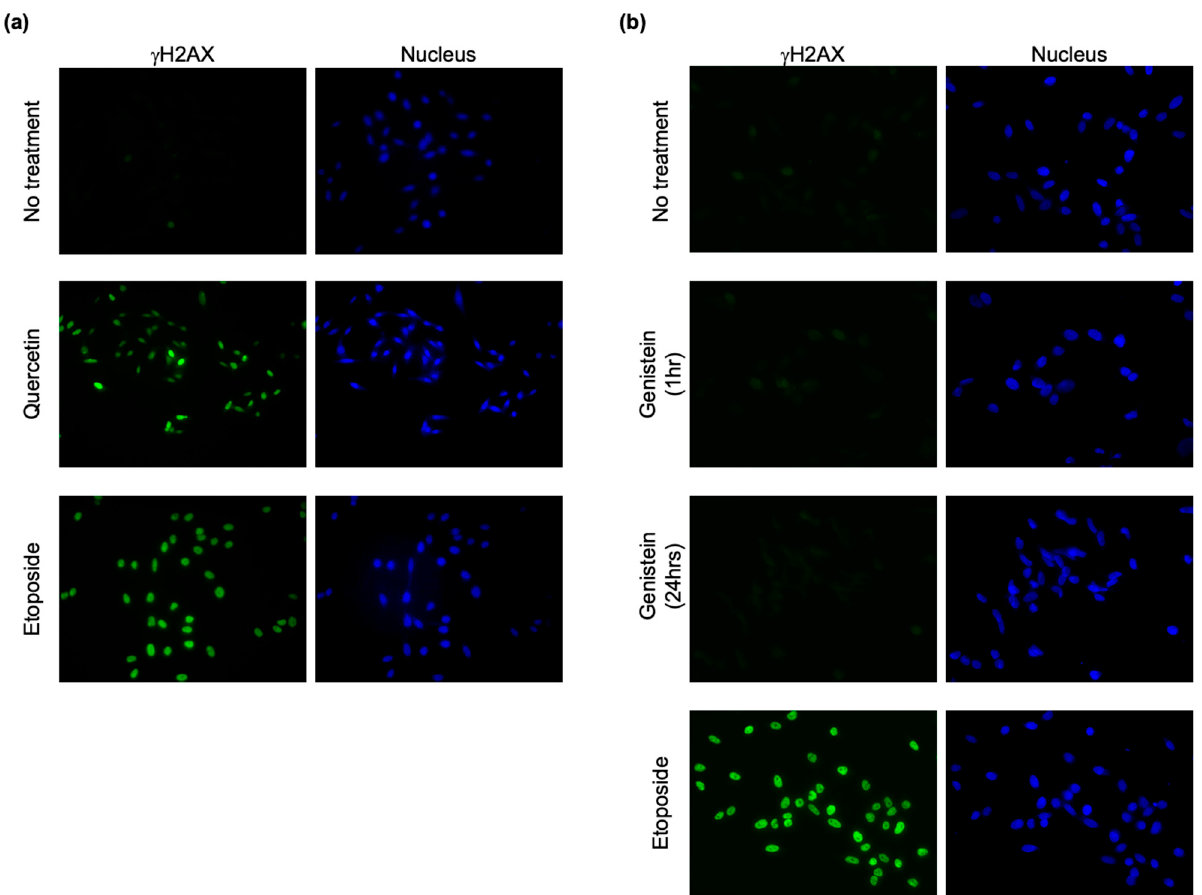
Figure 5. Immunofluorescence analysis of γ H2AX. HeLa cells were treated with 100 µ M quercetin ( a ) or 20 µ M genistein ( b ) and then subjected to immunofluorescence analysis. Etoposide was used as control. Nuclei were stained with DAPI. Experiments were independently performed three times.